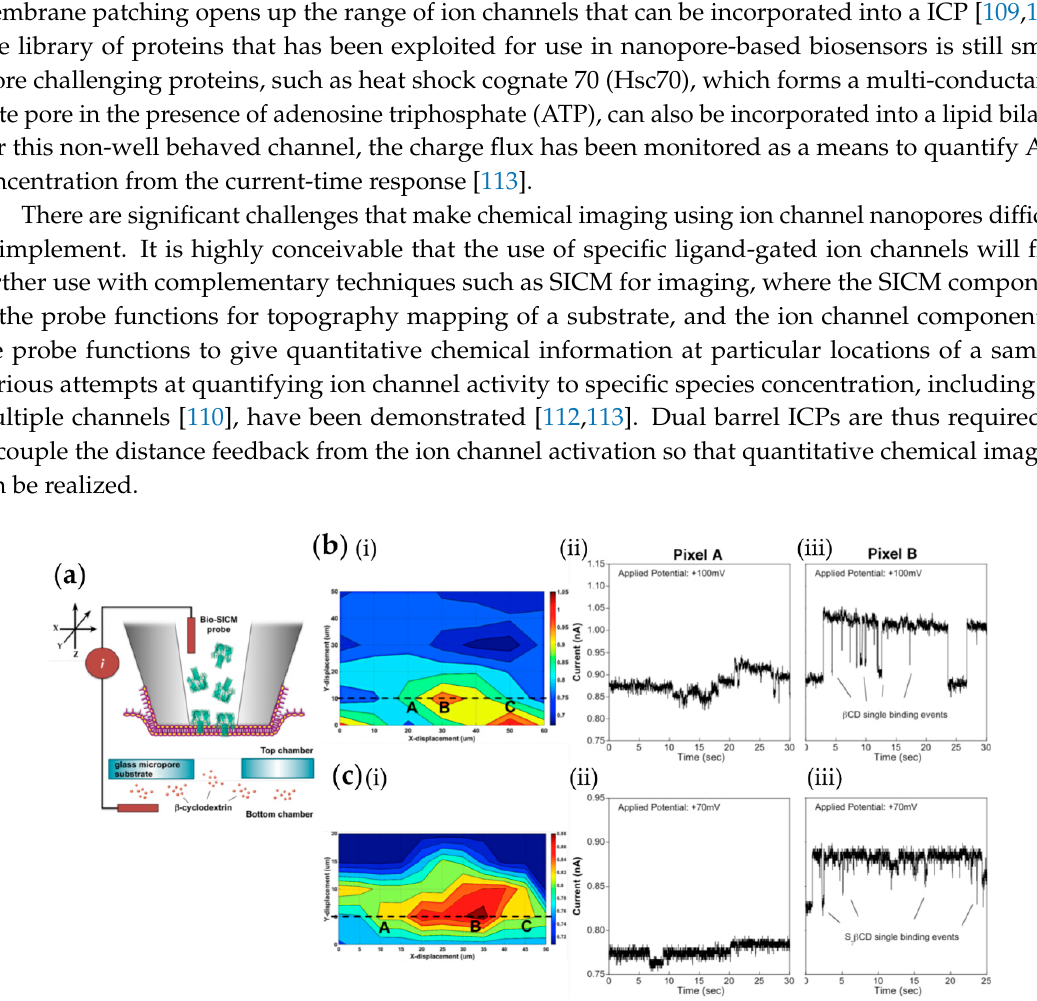
Figure 8. Single barrel ion channel probes can be used to image a substrate. ( a ) Schematic of the